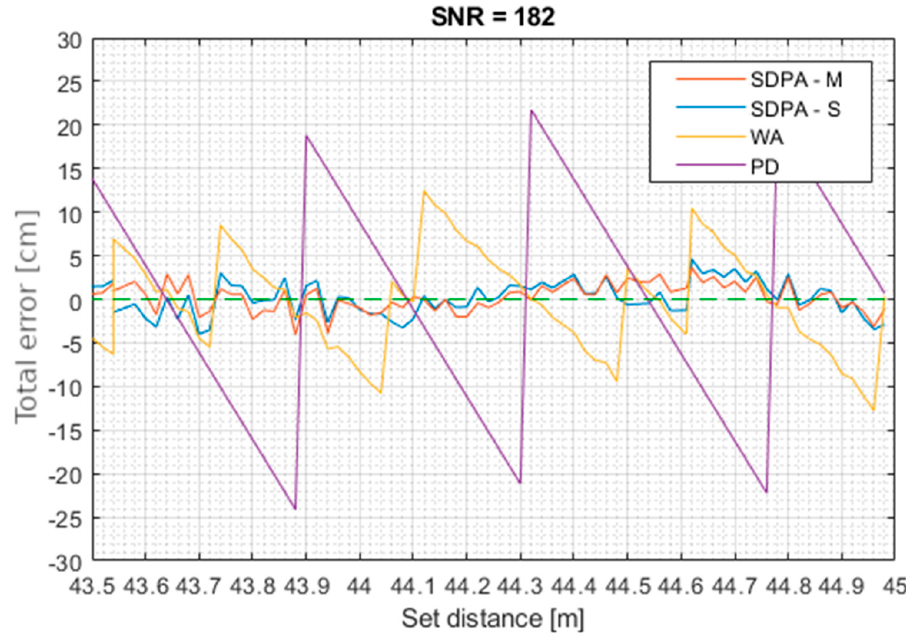
Figure 16. Trial 3. Total error of measurements as a function of set distance for SNR = 182.